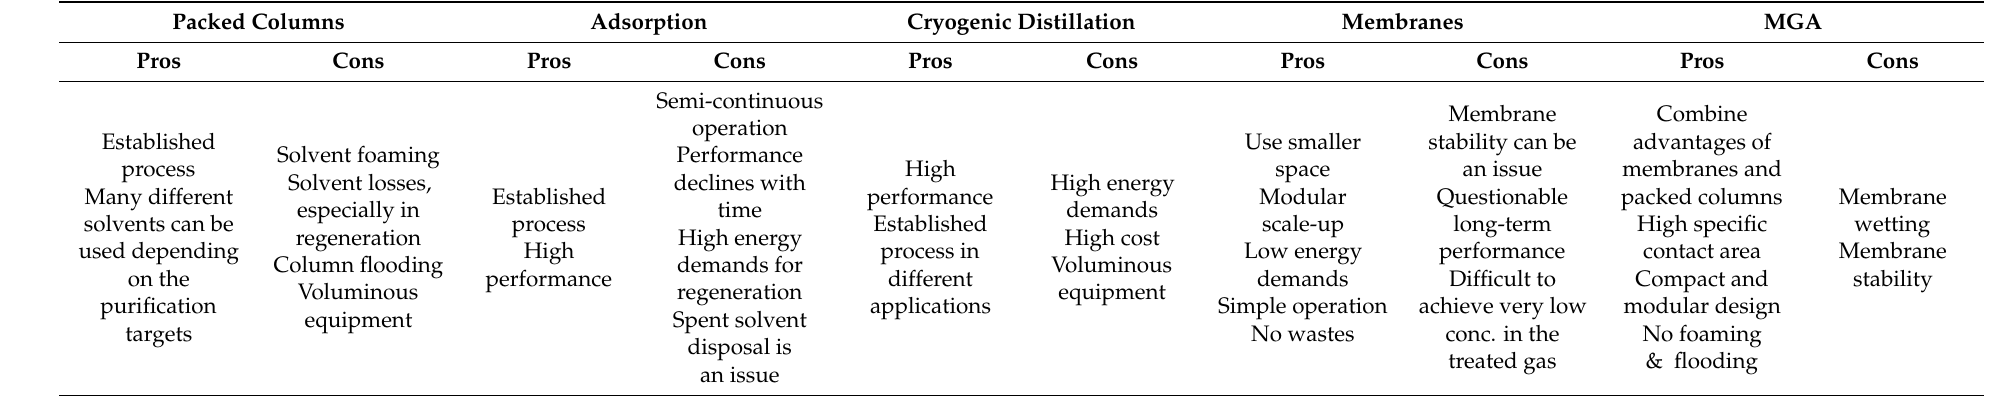
Table 3. Main advantages and disadvantages per main sour gas purification